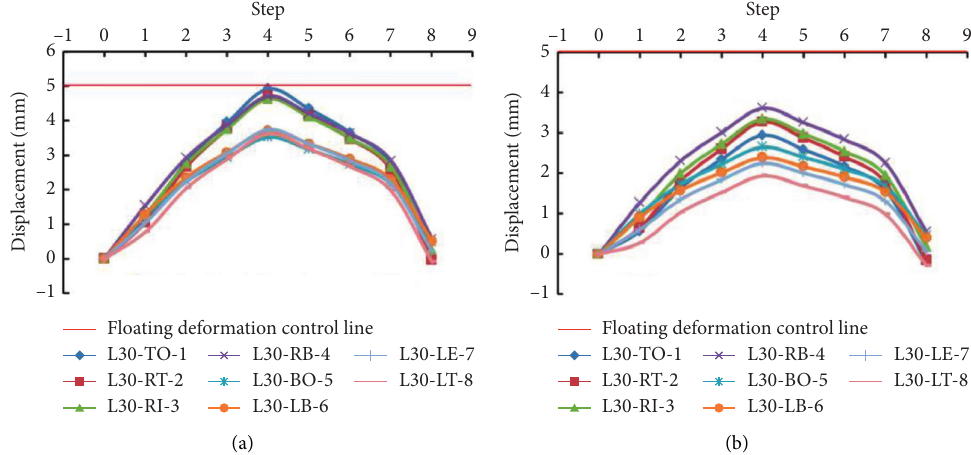
Figure 8: The vertical displacement of each monitoring point of each case when H / D is 5. (a) Working condition 21 ( I / D � 2.5) vertical displacement of monitoring point. (b) Working condition 26 ( I / D � 5) vertical displacement of monitoring